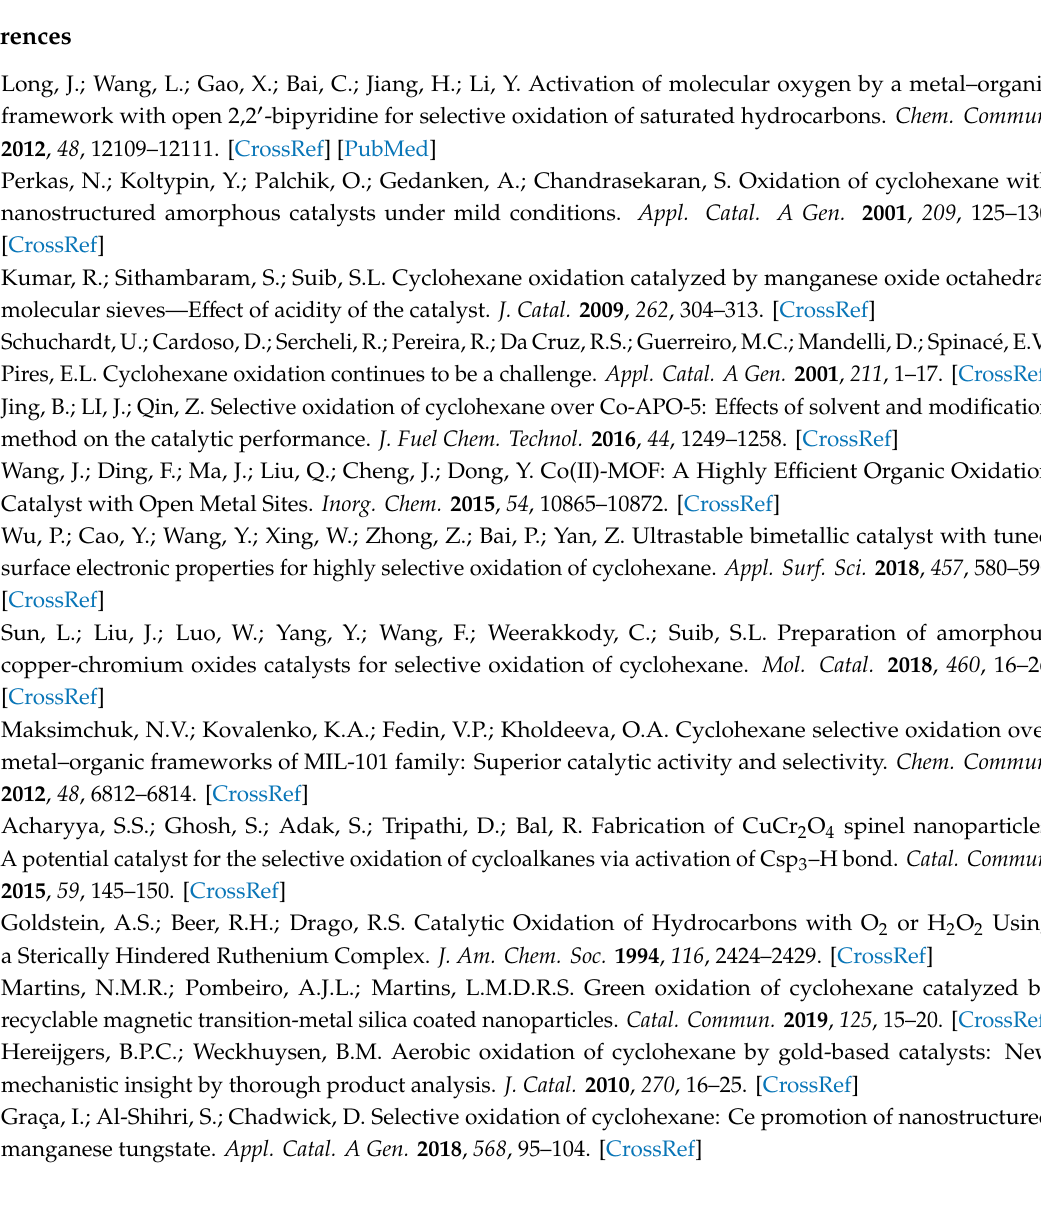
Figure S1: FT-IR spectra of H 2 bpydc, H 2 bpydc-KVO(O 2 ) 2 and H 2 bpydc-WO(O 2 ) 2 , Figure S2: XRD patterns of UiO-67-MoO(O 2 ) 2 and UiO-67-KVO(O 2 ) 2 in di ff erent drying temperature, Table S1: The ICP and elemental analysis results of H 2 bpydc-KVO(O 2 ) 2 and H 2 bpydc-WO(O 2 ) 2